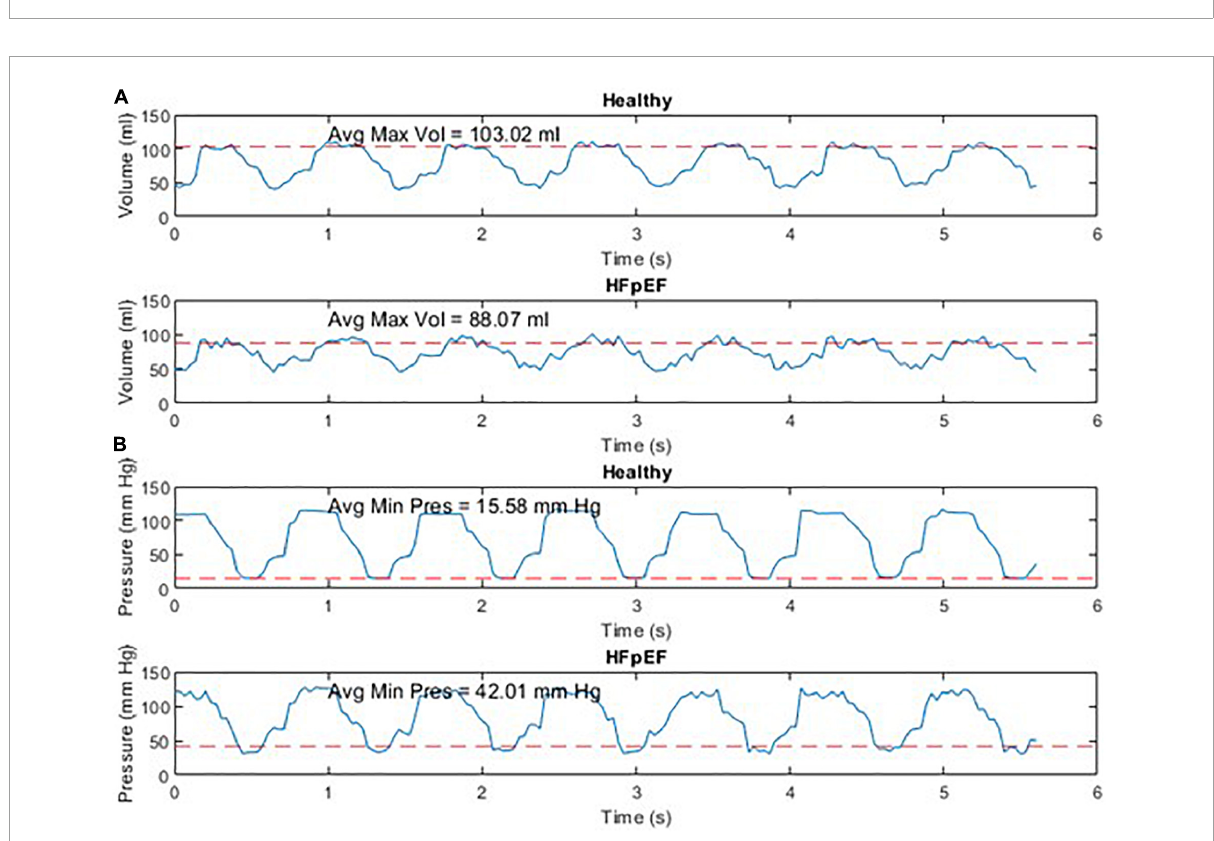
FIGURE4 Instantaneous volume and instantaneous pressure for healthy cardiac function and for HFpEF for the Mk I MCL (A) and the Mk II MCL (B)